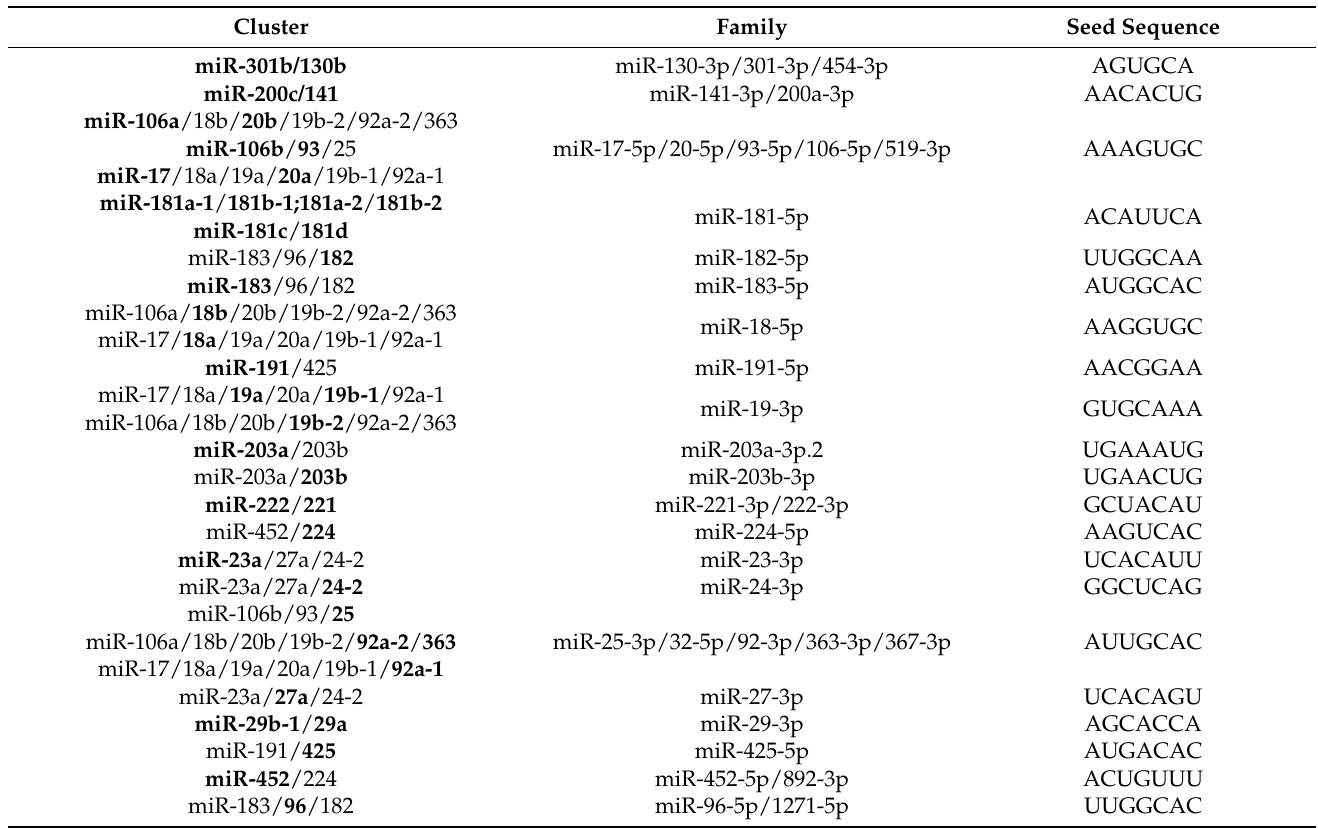
Table 3. Table of miRNA families of selected miRNA clusters and their seed sequences. Family Seed